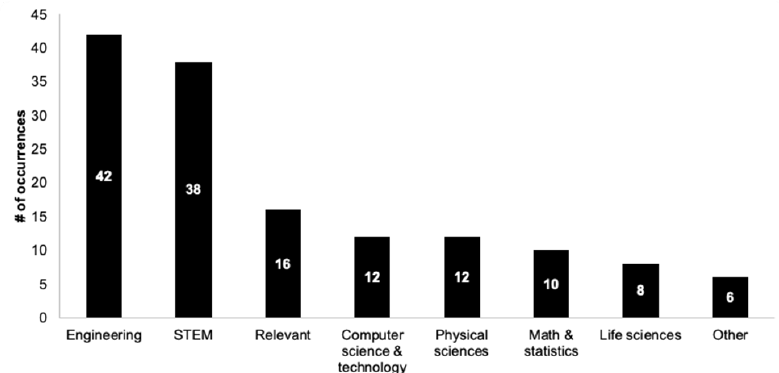
Figure 3 : Disciplines listed for an additional degree. Multiple